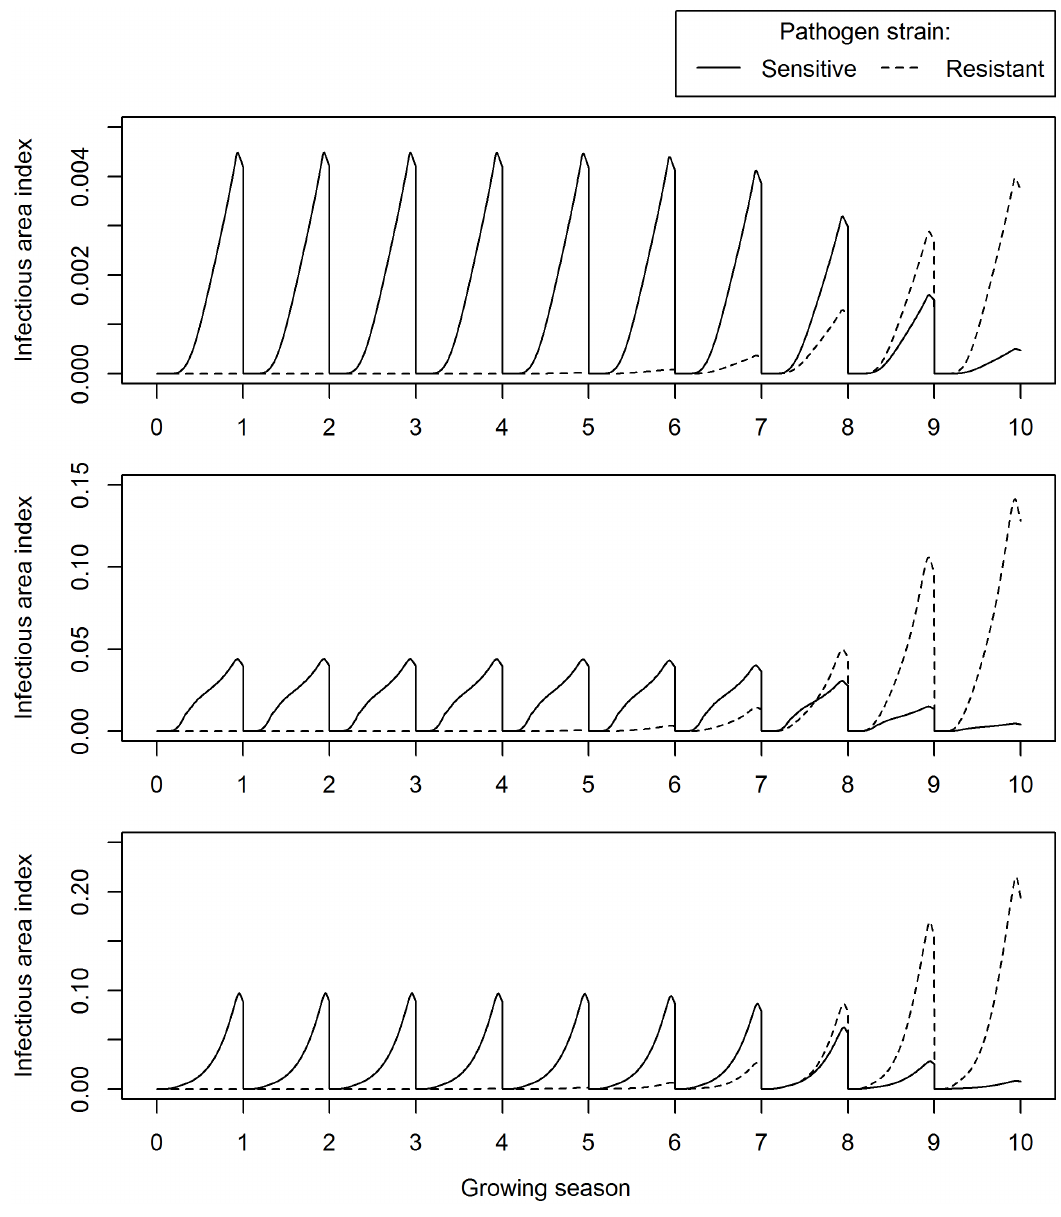
Fig 7. Time course of the sensitive and resistant pathogen strain for a seed treatment. The simulation was run for a low fungicide breakdown rate and a constant seed treatment uptake model. Blue and red lines indicate fungicide-sensitive and fungicide-resistance area index, respectively. Top panel: leaf layer 11. Middle panel: leaf layer 5. Bottom panel: leaf layer 1. A seed treatment was applied at 4.5 mg/m 2 , which provides a HAD gain that approximates that of a T1 spray, and the simulation was run for 10 growing